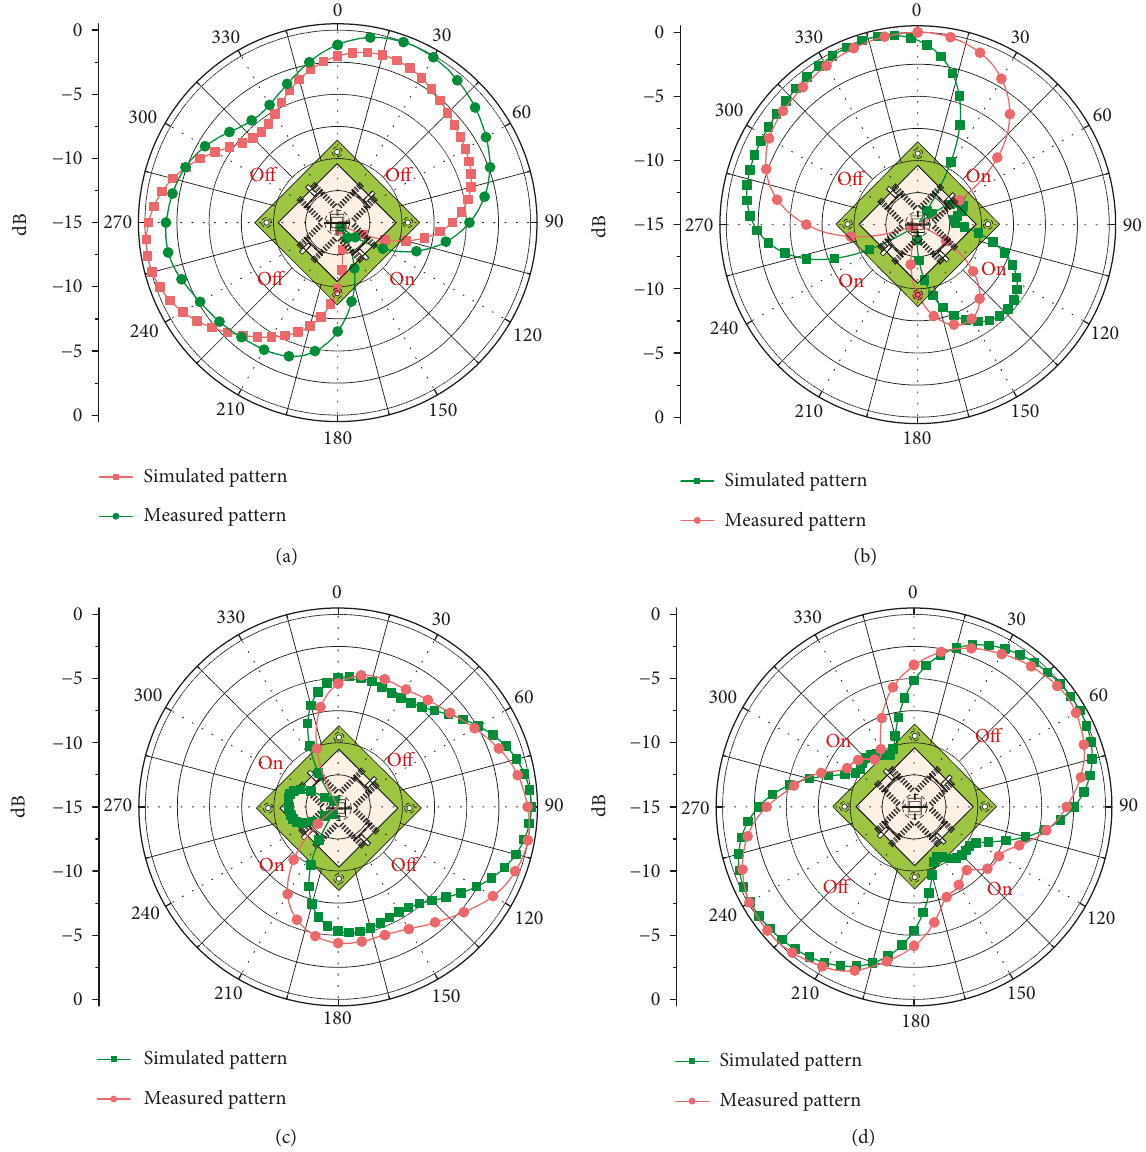
Figure 7: The simulated and measured normalized H plane patterns of states III (a), IV (b), V (c), and VI (d) of the proposed antenna at 5.2GHz, and the p-i-n modes indicated on the fi